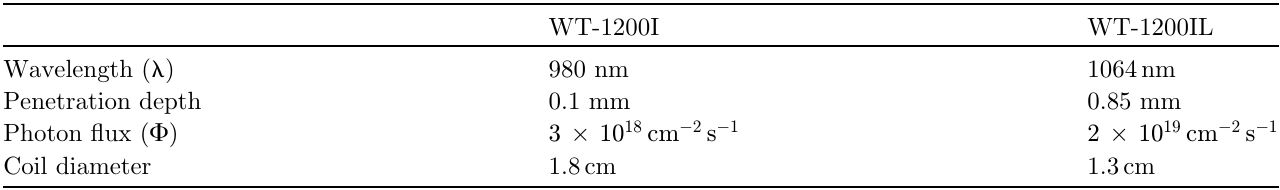
Table 1. Technical parameters of the earlier (WT-1200I) and the improved (WT-1200IL) measurement